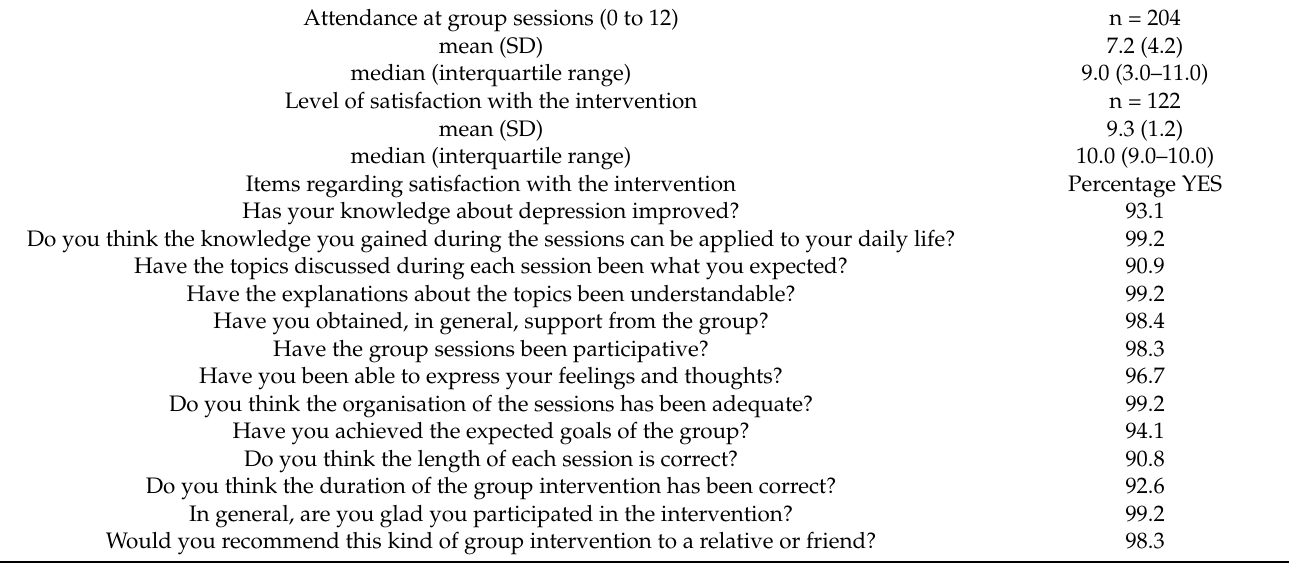
Abbreviations: SD, Standard